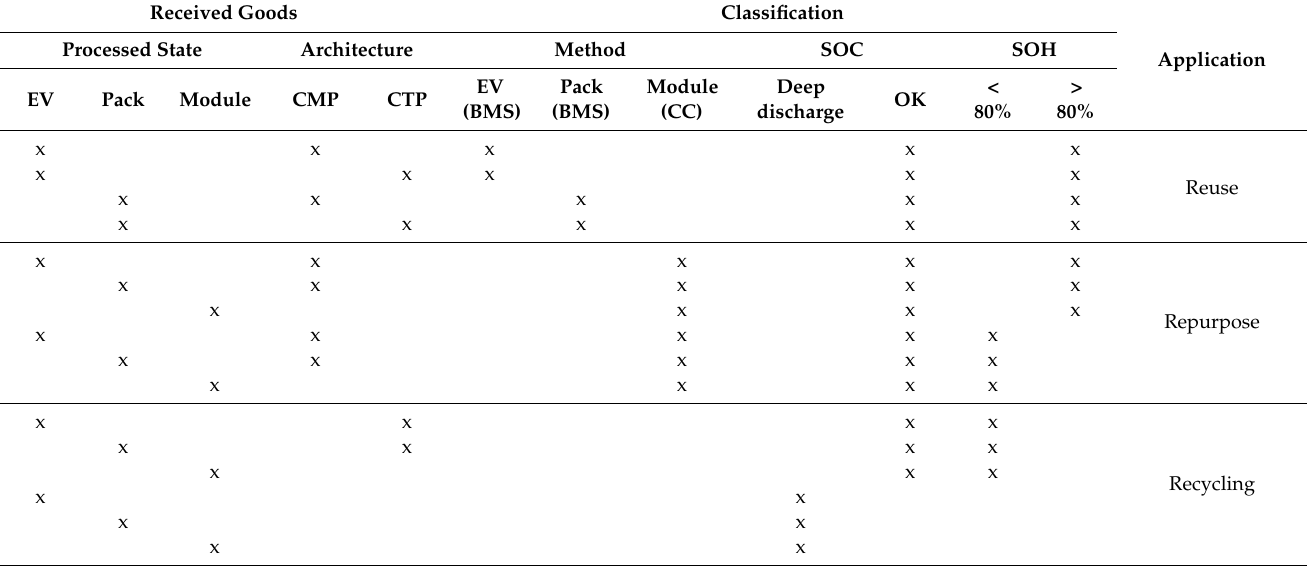
Figure 3. Downstream process map for used traction battery systems. Table 1. Decision criteria and application results embedded in the process